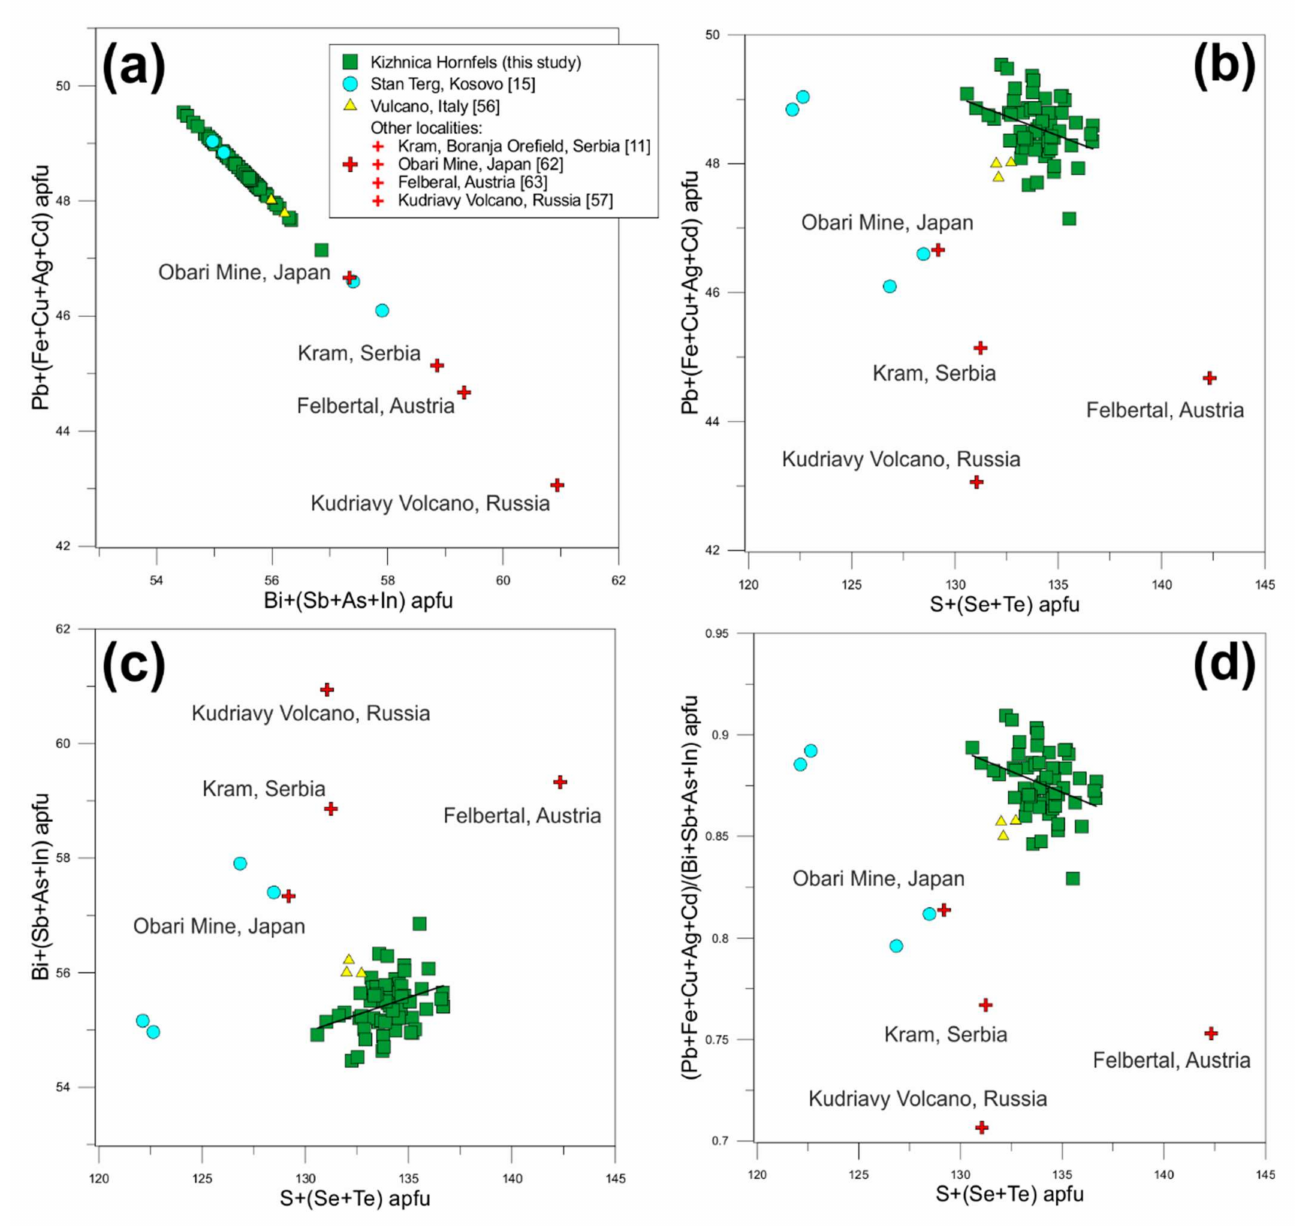
Figure 17. Binary plots showing the chemical composition of cannizzarite from the Kizhnica hornfels and known locations of cannizzarite from the literature [11,15,56,57,62,63]: ( a ) Pb + (Fe + Cu + Ag + Cd) vs Bi + (Sb + As + In) (apfu); ( b ) Pb + (Fe + Cu + Ag + Cd) vs S + (Se + Te) (apfu); ( c ) Bi + (Sb + As + In) vs S + (Se + Te) (apfu); ( d ); (Pb + Fe + Cu + Ag + Cd)/(Bi + Sb + As + In) vs S + (Se + Te)